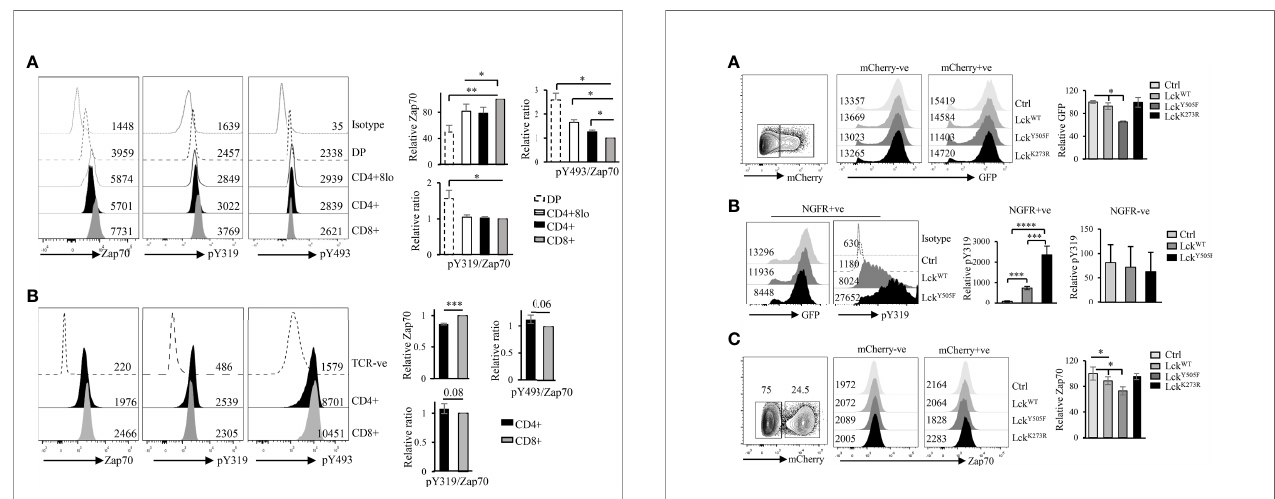
FIGURE 2 | Zap70 stability inversely correlates with relative phosphorylation of the protein in thymocytes and mature T cell subsets. Histogram shows a representative example of phospho staining of thymic (A) and splenic (B) T cell subsets from WT mice. Bar graph shows compilation of relative amount of total Zap70 and pY493 and pY319 Zap70 (expressed as ratio of phospho MFI over total Zap70 MFI) normalized to that in CD8 SP thymocytes or CD8 splenic T cells. MFI values are shown in the histograms (6 mice from 3 independent experiments) * p < 0.05, ** p < 0.005, and *** p < 0.0005.